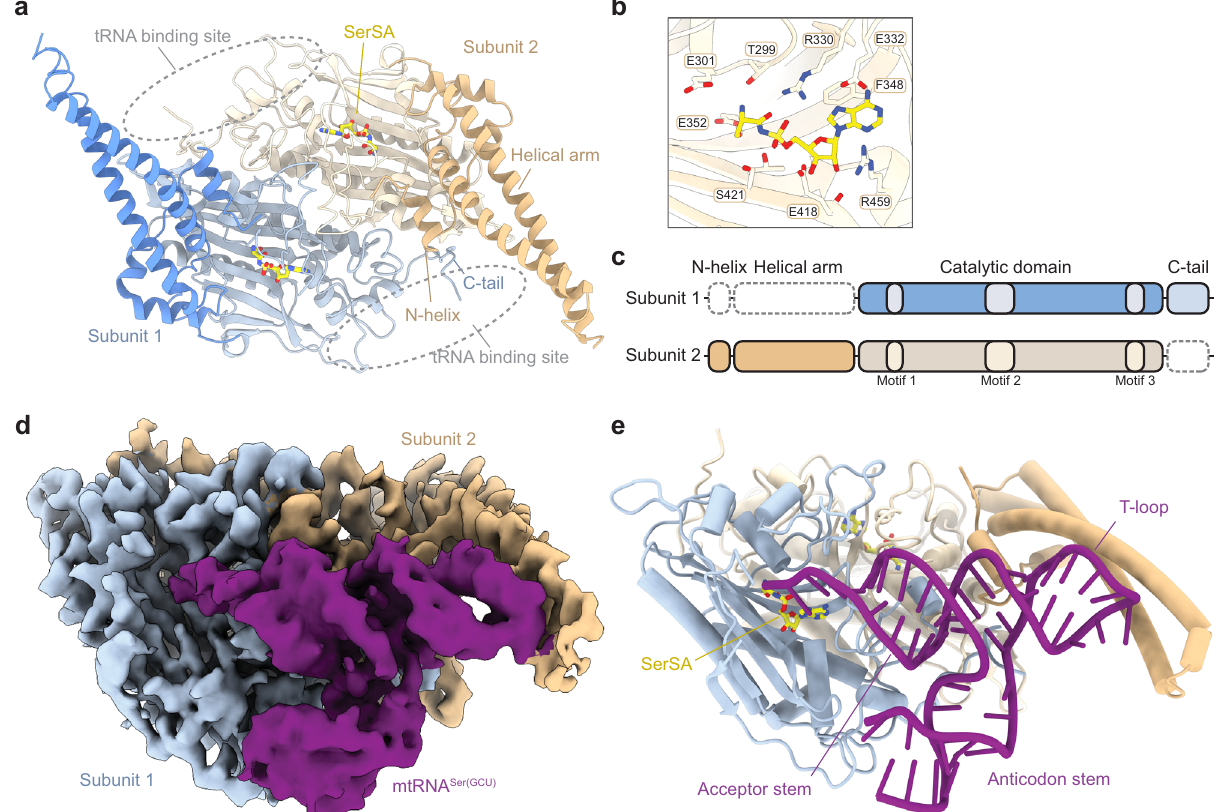
Fig.1|StructuresofhumanmSerRSboundtoSerSAandmtRNA Ser(GCU) .a Crystal structure of human mSerRS bound to SerSA (yellow sticks). mSerRS is shown in cartoon presentationinlightblue (subunit1)and wheat(subunit2).Dashedcircles indicatethetwoidenticaltRNAbindingsitesonoppositesidesofthemSerRShomo dimer. b Binding pocket for SerSA in the mSerRS crystal structure. Interacting residues are shown as sticks. c Domain presentation of mSerRS. Dashed lines